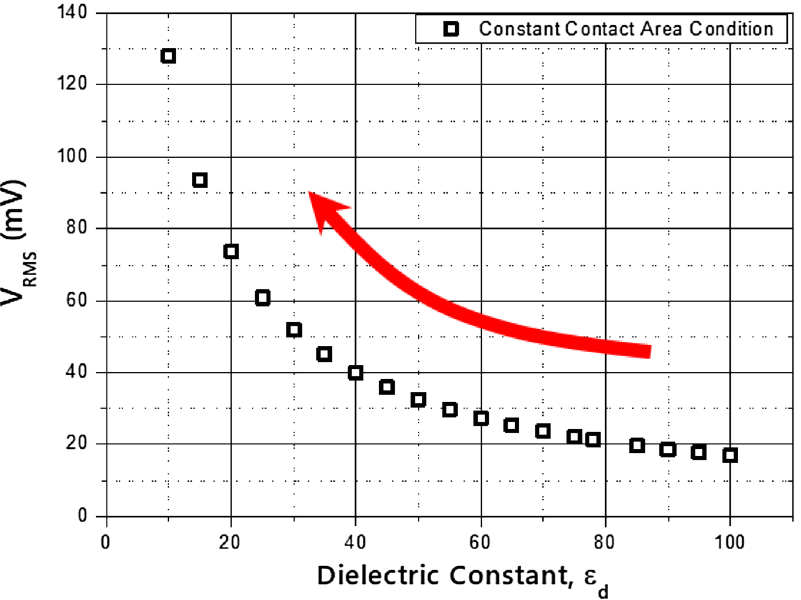
Figure 11. Relation between the dielectric constant and RMS voltage output calculated from the RC-circuit